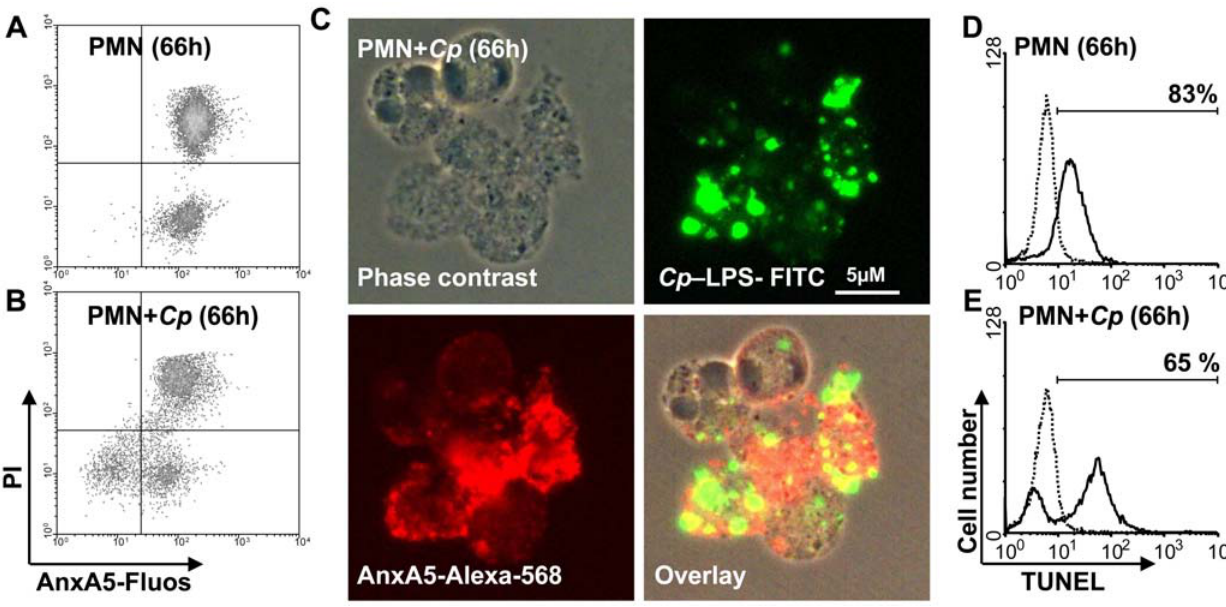
Figure 2. C.pneumoniae hides inside PS- positive PMN. To analyze early and late apoptotic markers, PMN were infected with C. pneumoniae or left in medium alone. Using Anxa5-fluos and propidium iodide (PI) staining we could show that both non- infected ( . 95%, A ) and C. pneumoniae - infected (82% 6 12%, B ) PMN become PS- positive within 66 h without significant changes in the amount of PI- positive necrotic cells (representative experiment out of 3). To visualize whether C. pneumoniae - infected PMN stain positive for PS we performed a double staining using a FITC- labeled anti- C. pneumoniae LPS mAb and Alexa568-labeled AnxA5 ( C ). In contrast, late apoptotic cells as determined by TUNEL staining (closed line) were more often found in the medium control than in C. pneumoniae - infected PMN ( D , E ; representative experiment out of